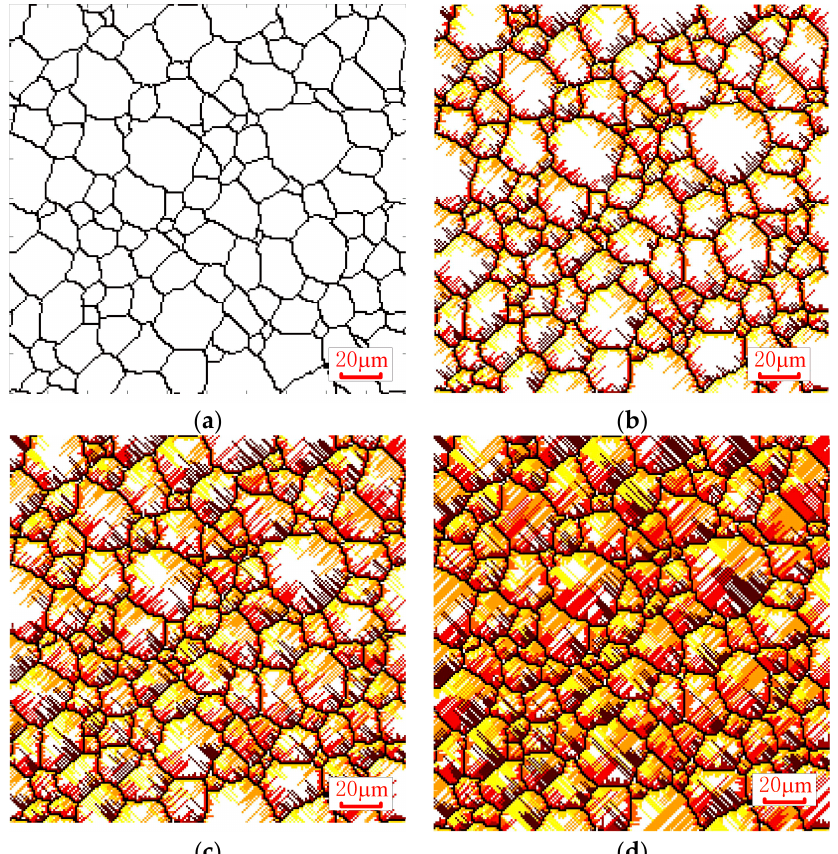
Figure 7. Martensite transformation with different temperatures. ( a ) T = 330 °C ; ( b ) T = 280 °C ; ( c ) T = 180 °C ; ( d ) T = 80 ℃ .